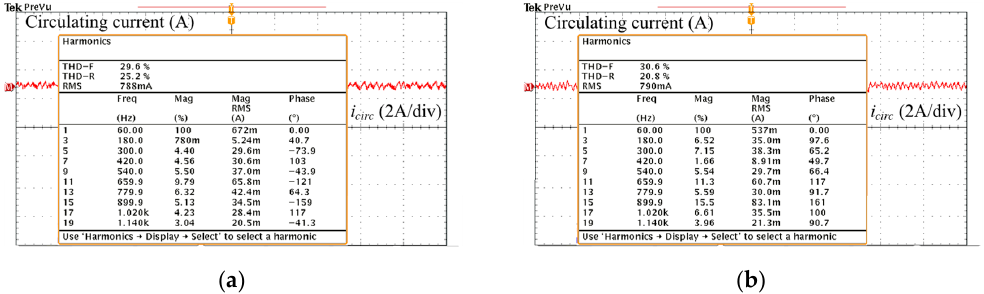
Figure 13. Frequency spectrum of phase output current: ( a ) without switching loss balancing control (THD = 1.57%, RMS = 1.38 A); ( b ) with switching loss balancing control (THD = 1.59%, RMS = 1.38A).